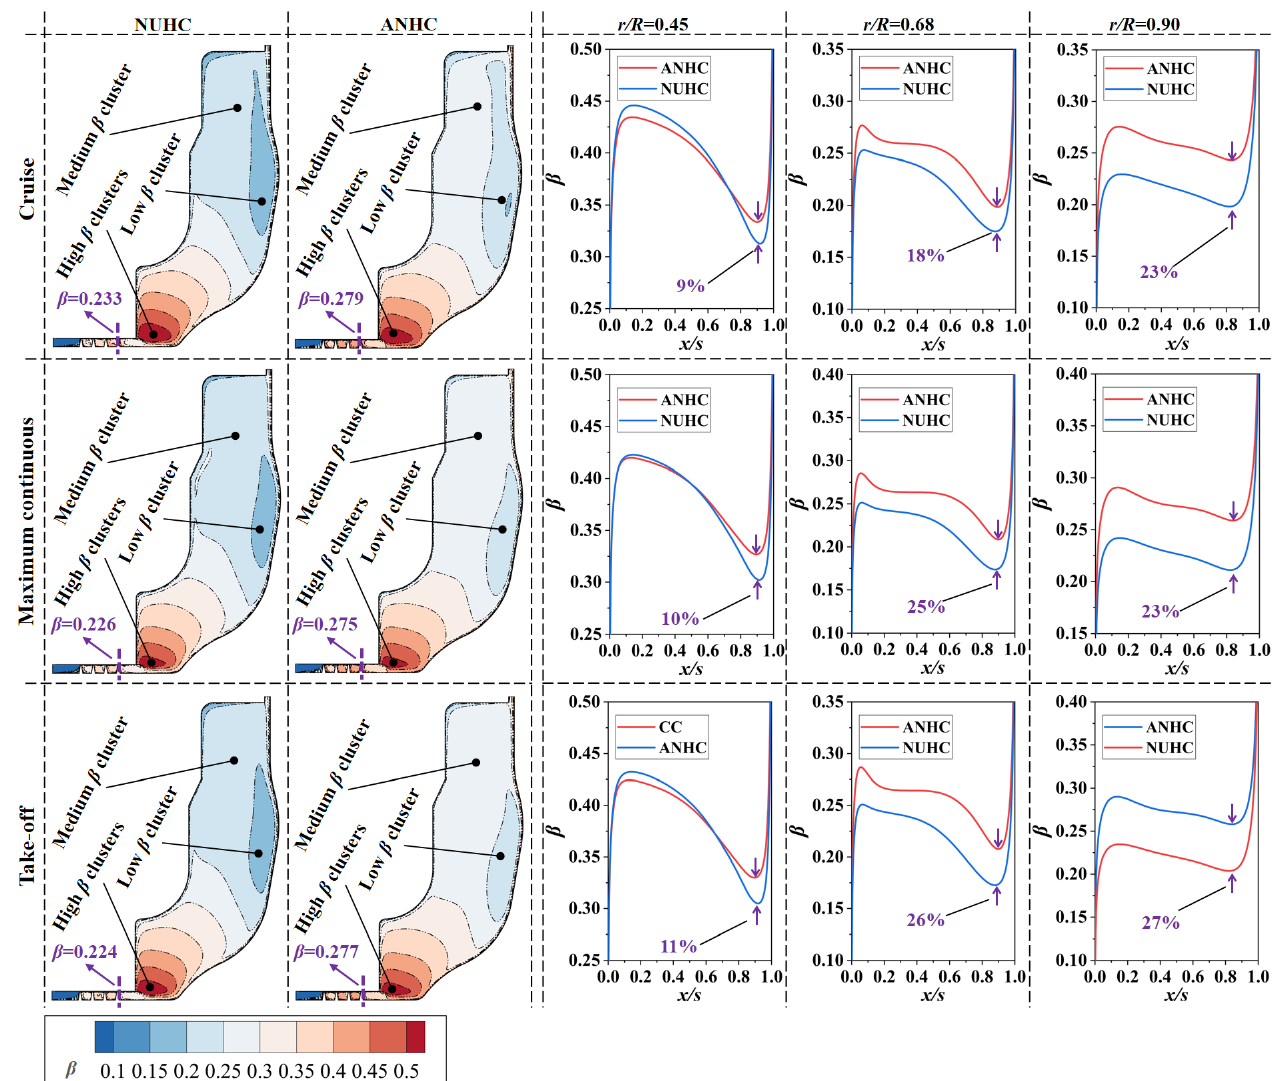
Figure 24. Swirl ratio distributions under ANHC and NUHC.